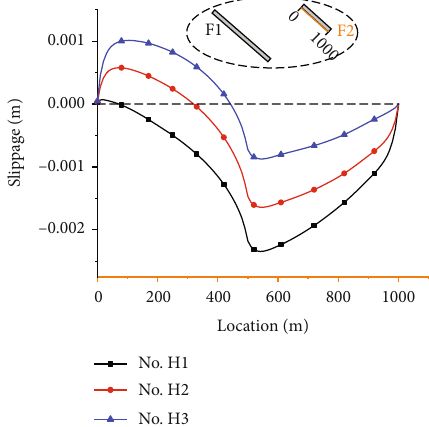
Figure 12: The fault slippage of F2 according to di ff erent fracturing regions (Nos. H1-H3).